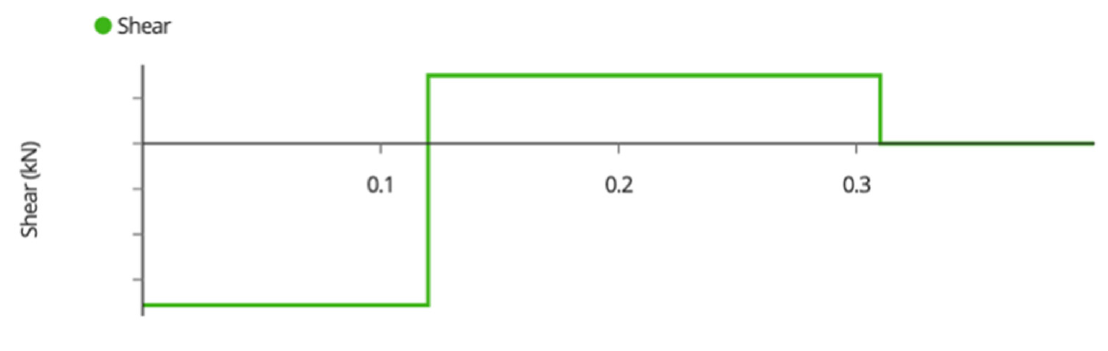
Figure A11. Post-Bending Moment Diagram. The deflection diagram of the post is seen in Figure A12, Figure A12. Post Deflection Diagram.